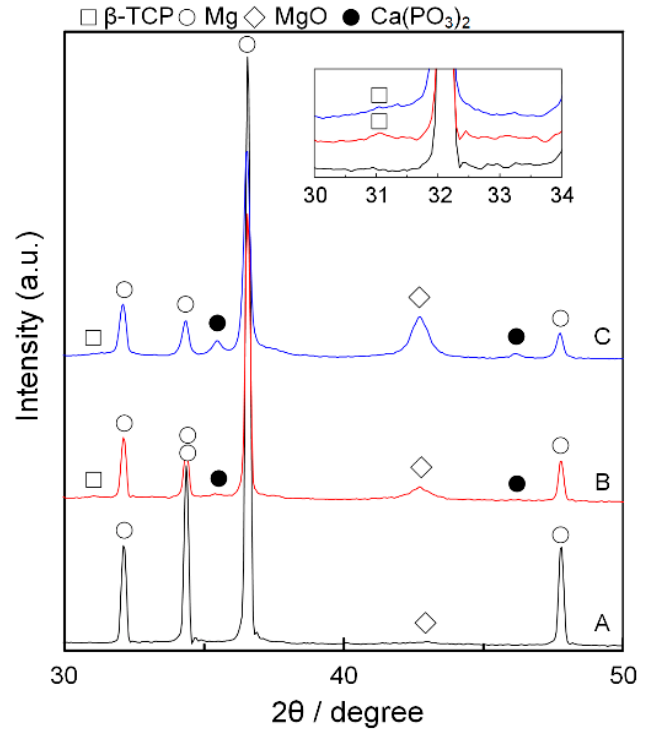
Figure 2. XRD patterns of ( A ) the sintered Mg, ( B ) Mg/10% β -TCP, ( C ) Mg/20% β -TCP before immersion. Inset shows magnified patterns with small peaks of β -TCP.